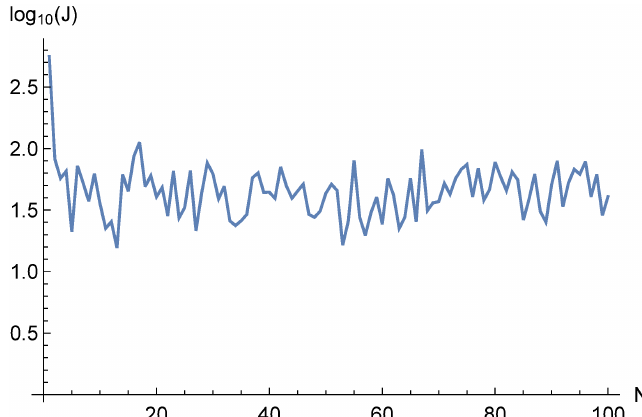
Figure 6. Plot of training loss J history of neural network solution nn 5 ( x ) (9) to problem (30), parameter value s = 0.1, with respect to number N of training epochs. Number of hidden layer neurons n = 5; sigmoid activation